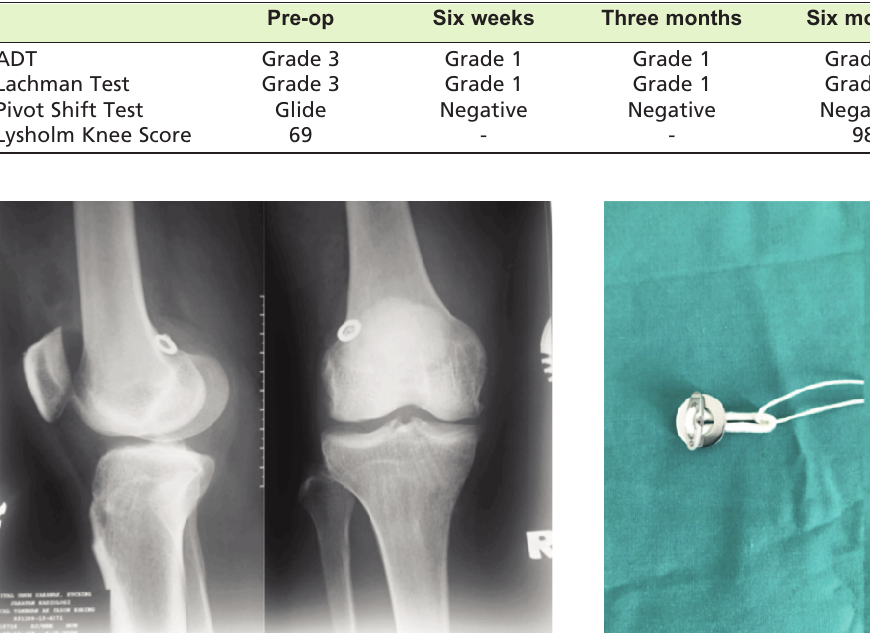
ADT, Lachman test, Pivot shift test and Lysholm knee score for the patient at pre-operative, post-operative six weeks, Table I: three months, six months and one